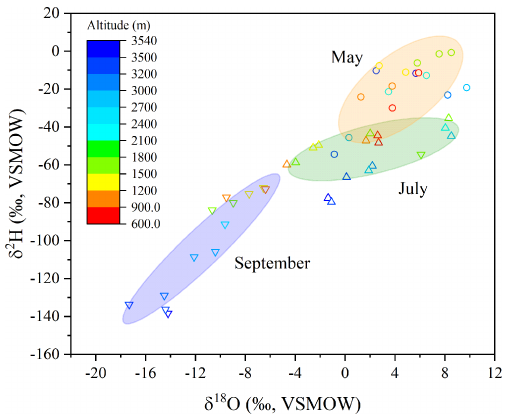
Figure 4. Correlation of leaf water δ 18 O and δ 2 H values across months and altitude. Leaf water δ 18 O and δ 2 H values were higher in May, intermediate in July, and lower in September, and while within each month, those isotopic values were relatively lower at high altitudes and higher in lower